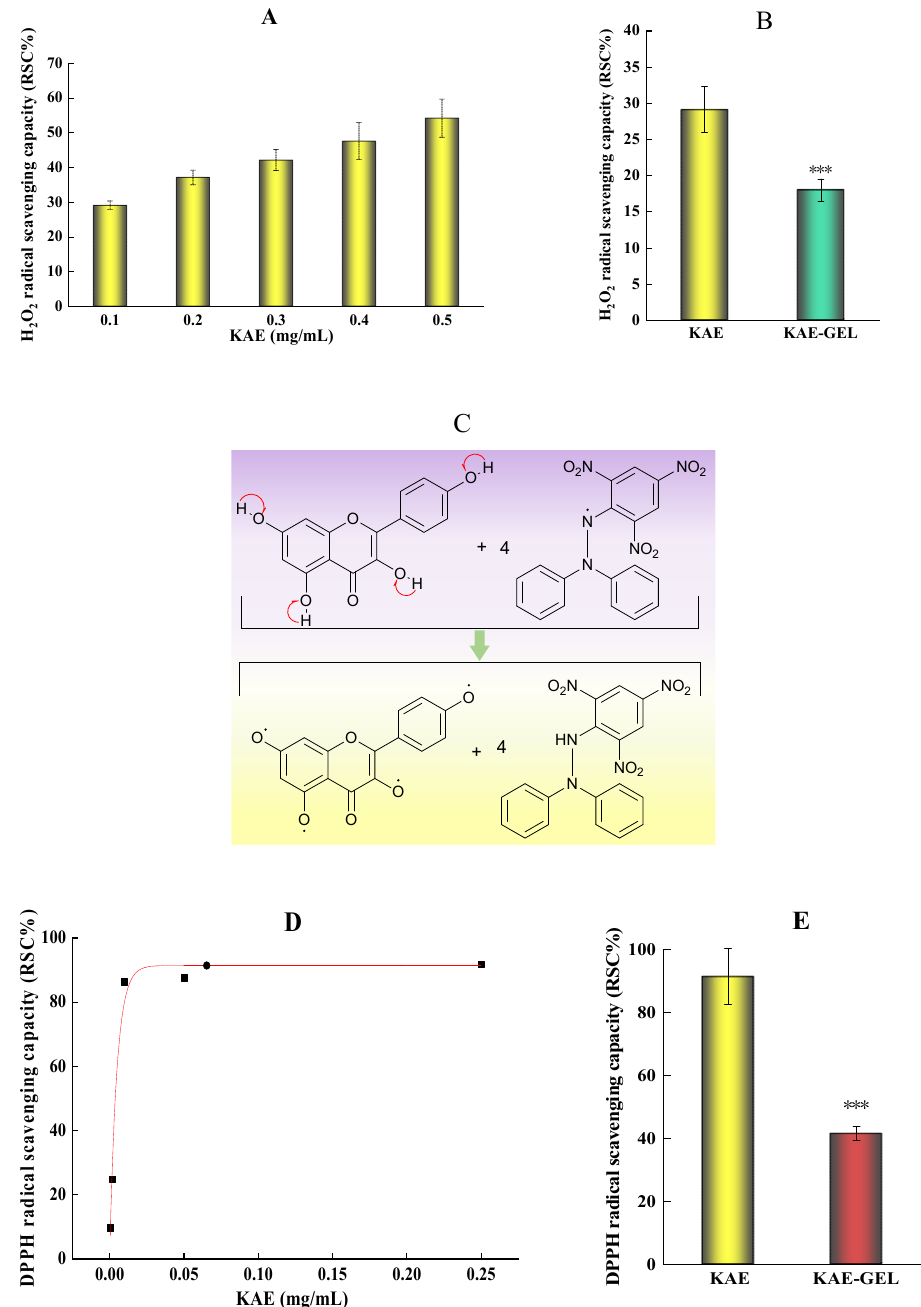
Figure 4. Free radical scavenging rate of KAE and KAE-GEL on H 2 O 2 and DPPH. ( A ) Antioxidant activities of different concentrations KAE on H 2 O 2 . ( B ) Antioxidant activities of 0.1 mg/mL KAE and KAE-GEL on H 2 O 2 . ( C ) DPPH radical scavenging mechanism. ( D ) Different concentrations KAE express the scavenging ability on DPPH free radical. ( E ) 0.1 mg/mL KAE and KAE-GEL express the scavenging ability on DPPH free radical. This difference is statistically significant, p *** < 0.001.